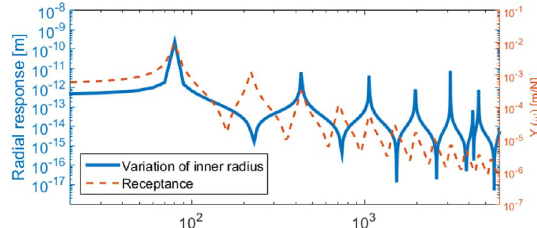
Figure 15. Geometric con fi guration of symmetric and asym- metric